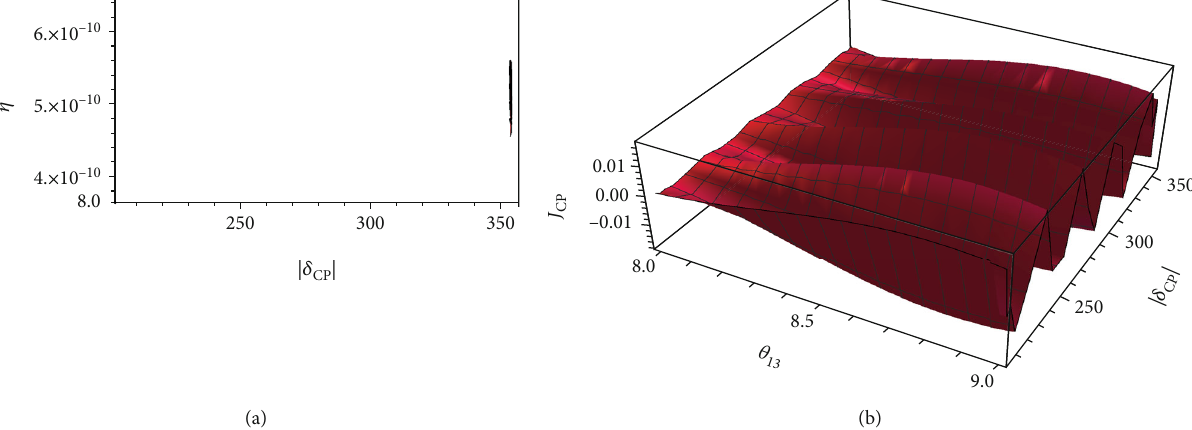
(in the light of CP = 0 : 0657 eV, as a result of 3 , values for best fi t value of θ = 48 : 6 ° of Δχ 2 = 6 : 2 [14] as a result of CP 23